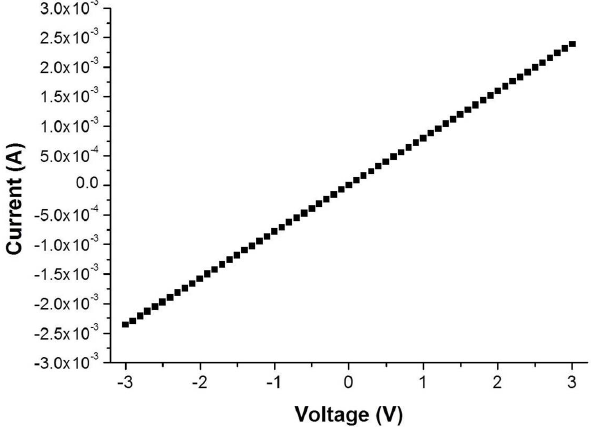
Figure 6. The chemosensor current–voltage curve.